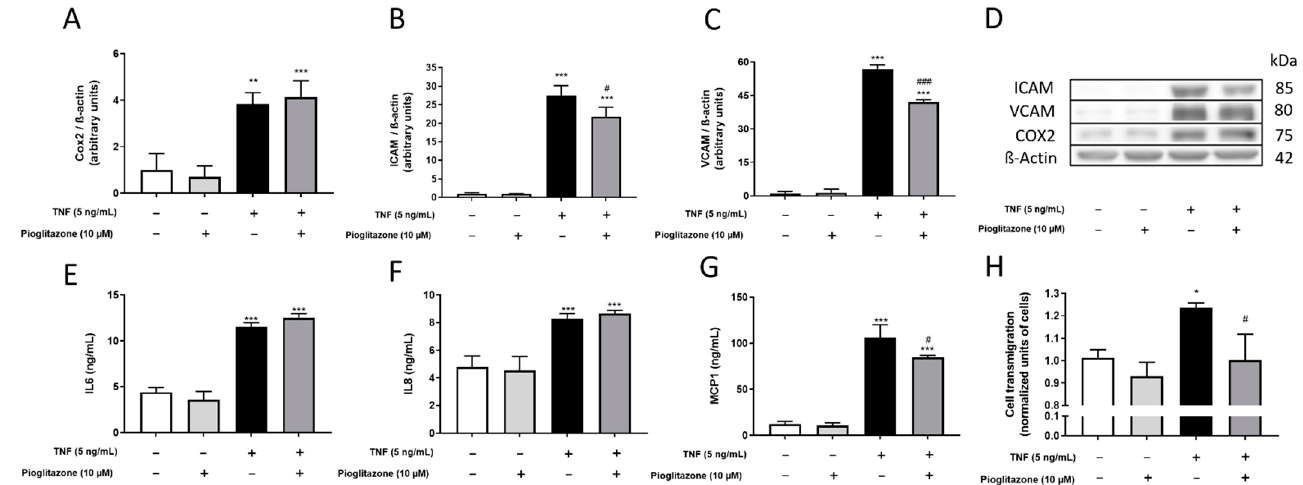
Figure 5. Effects of pioglitazone on TNF α -induced increases in inflammation-associated factors and monocyte transmigration. BLECs were treated with 5 ng/mL of TNF α for 24 h following pre- treatment with 10 µM pioglitazone for 24 h. Expression of inflammatory proteins COX-2, VCAM-1 and ICAM-1 were assessed by Western blotting ( A – D ). Co-culture supernatants were collected, and secretion of IL-6, IL-8 and MCP1 by endothelial cells was assessed by ELISA ( E – G ). Stained monocytes were co-cultured alongside BBB co-cultures, and their transmigration was assessed via colorimetric assays ( H ). Results are shown as mean ± standard deviation (n = 3) and were analyzed via one-way ANOVA followed by Tukey’s post hoc test. *, **, *** p < 0.05, 0.01 and 0.001 in comparison to control groups; #, ### p < 0.05 and 0.001 in comparison to TNF α -treated group.